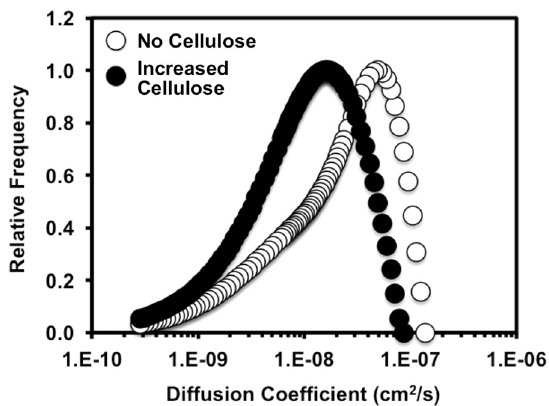
Fig. 5 Relative frequency of diffusion coef fi cients of extracted EPS (no cellulose and increased cellulose) measured using